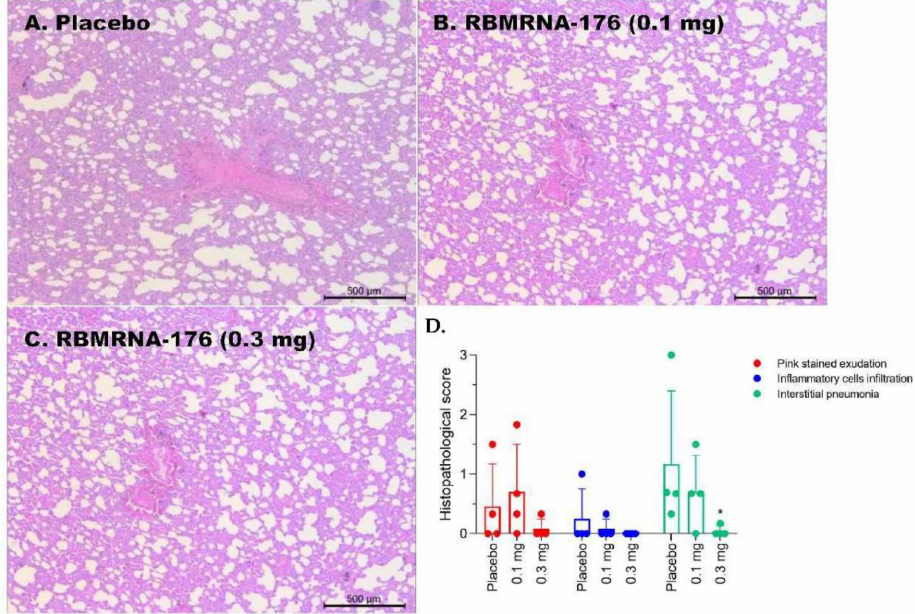
Figure 9. Histopathologic changes in lungs from RBMRNA-176-vaccinated rhesus macaques chal- lenged with SARS-CoV-2. Pathological changes in the hematoxylin and eosin (H&E) staining of paraffin-sectioned lung tissues (original magnification: 50 × ; scale bar: 500 µ m) ( A – C ). Comparison of histopathological scores between vaccinated and normal macaques ( n = 4) ( D ). * p < 0.05, compared with placebo-treated control without RBMRNA-176